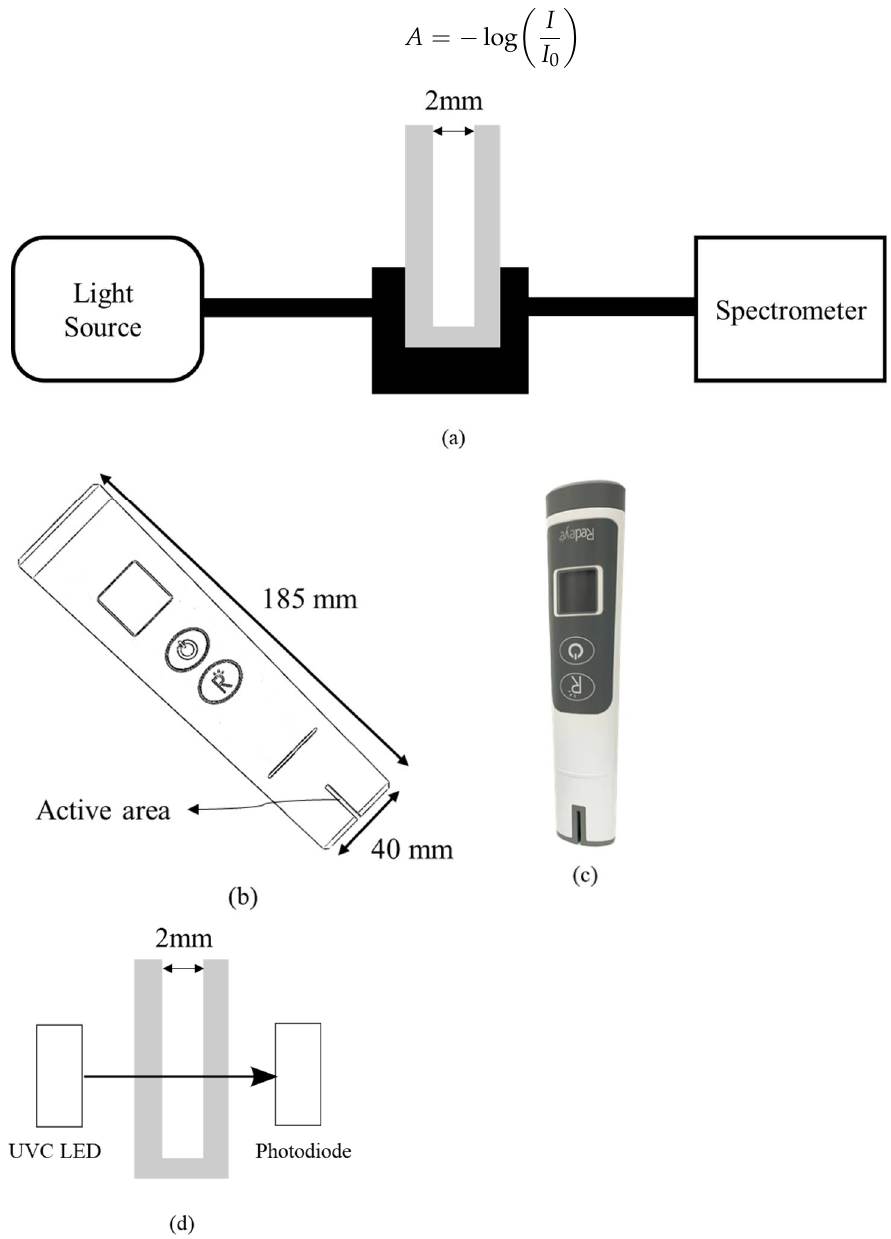
Figure 1. ( a ) The spectral analyzer system set up; ( b ) the portable proof-of-concept prototype for testing uric acid in urine; ( c ) the photograph of the real device; ( d ) the structure of the active area.